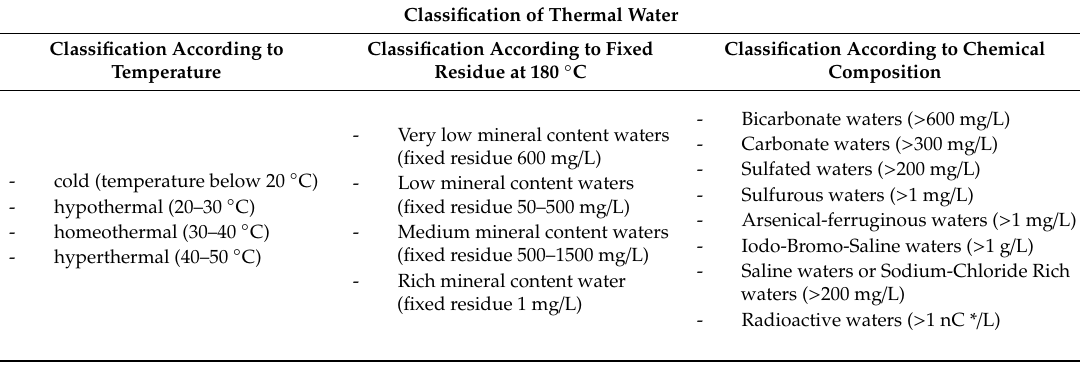
Table 1. Chemico-physical properties: classification of thermal